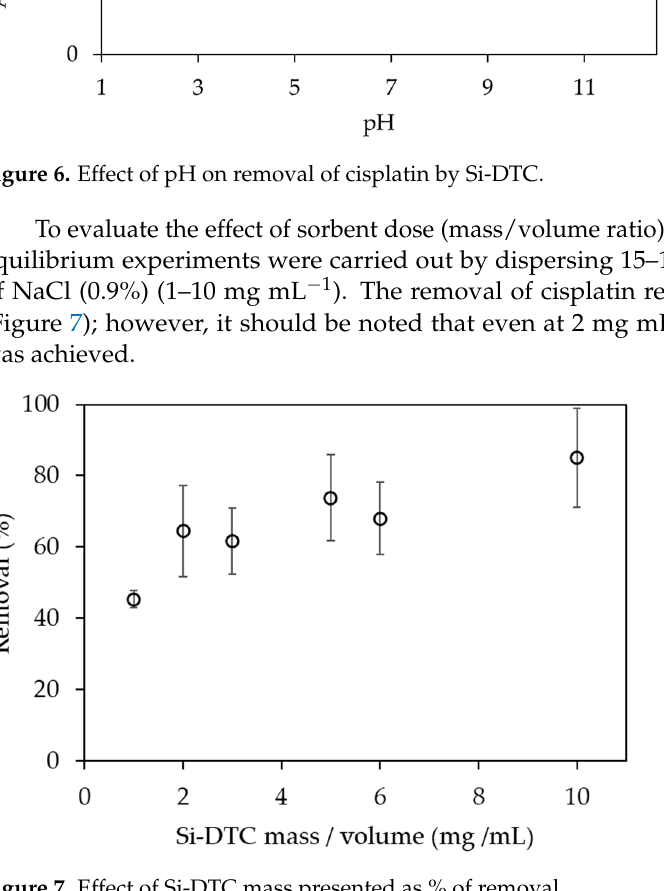
Figure 7. Effect of Si-DTC mass presented as % of removal.